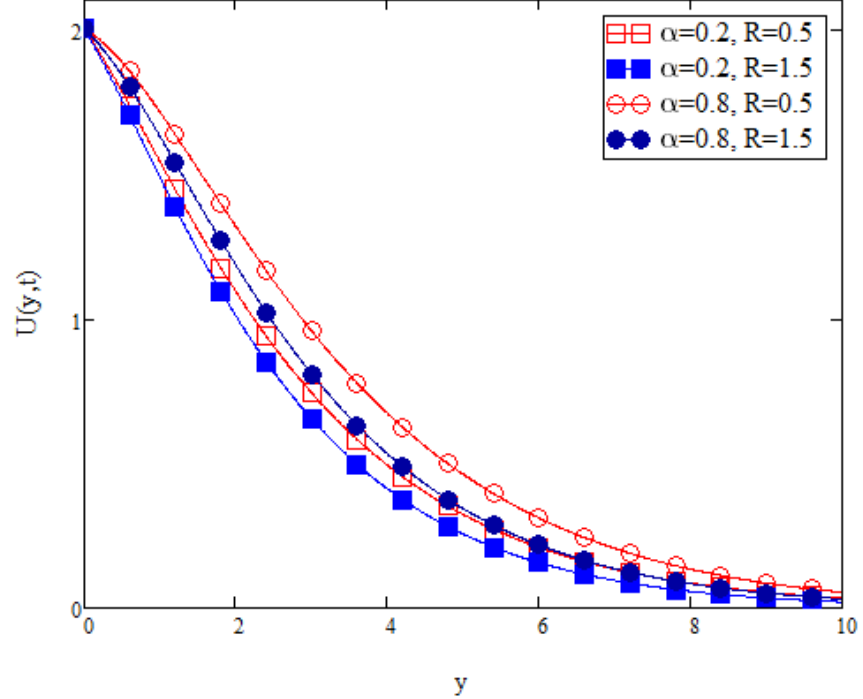
Figure 17. Variation in velocity profile due to variations in R and α